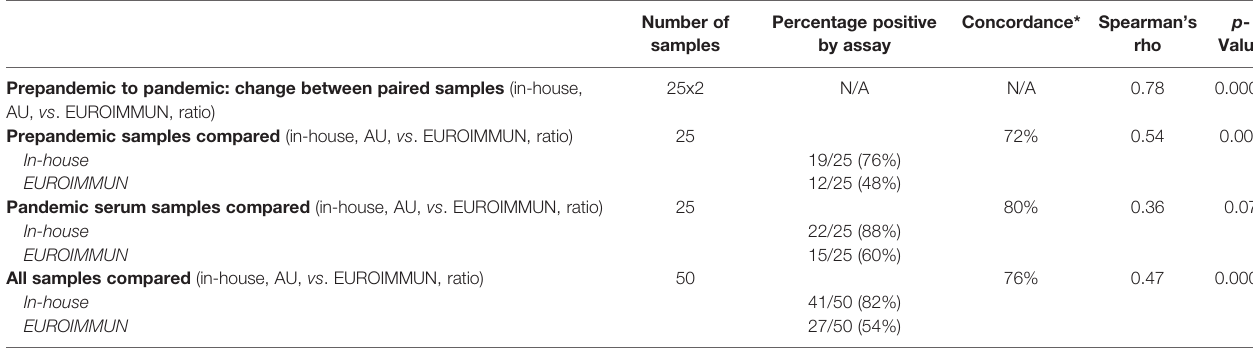
TABLE 2 | Correlation analyses and concordance between results of the IgA in-house S1 spike assay and the EUROIMMUN IgA ELISA.